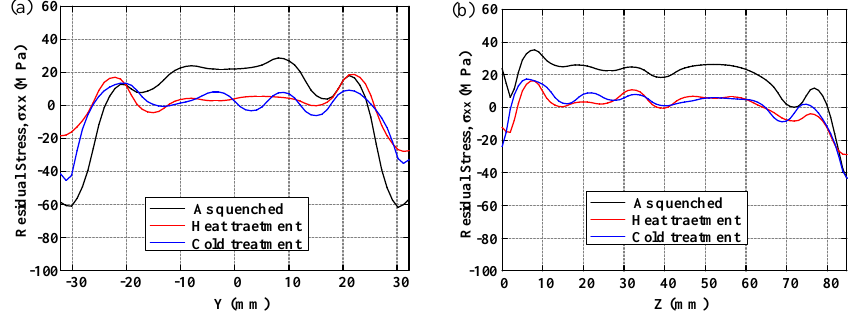
Figure 10. The distribution of longitudinal residual stress ( σ zz ): ( a ) along the x -direction at y = 0 mm; ( b ) along the y -direction at x = 0 mm.